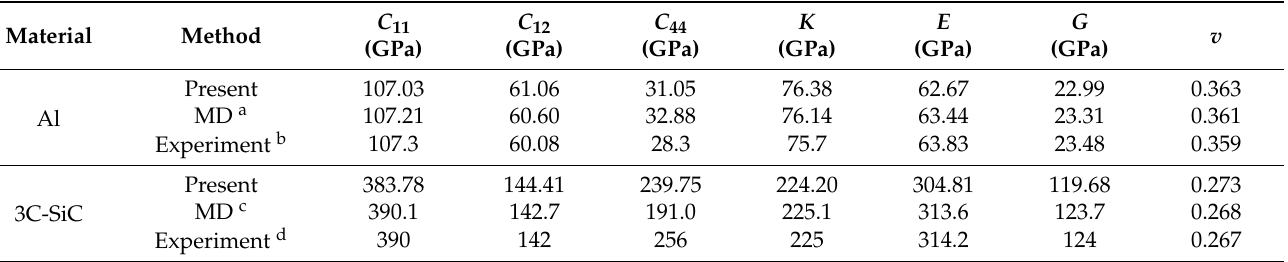
Table 6. The elastic constants, bulk modulus, Young modulus, shear modulus, and Poisson ratio obtained by the present MD simulations using the EAM and Tersoff potential functions and compared with those obtained by other MD simulations or experimental